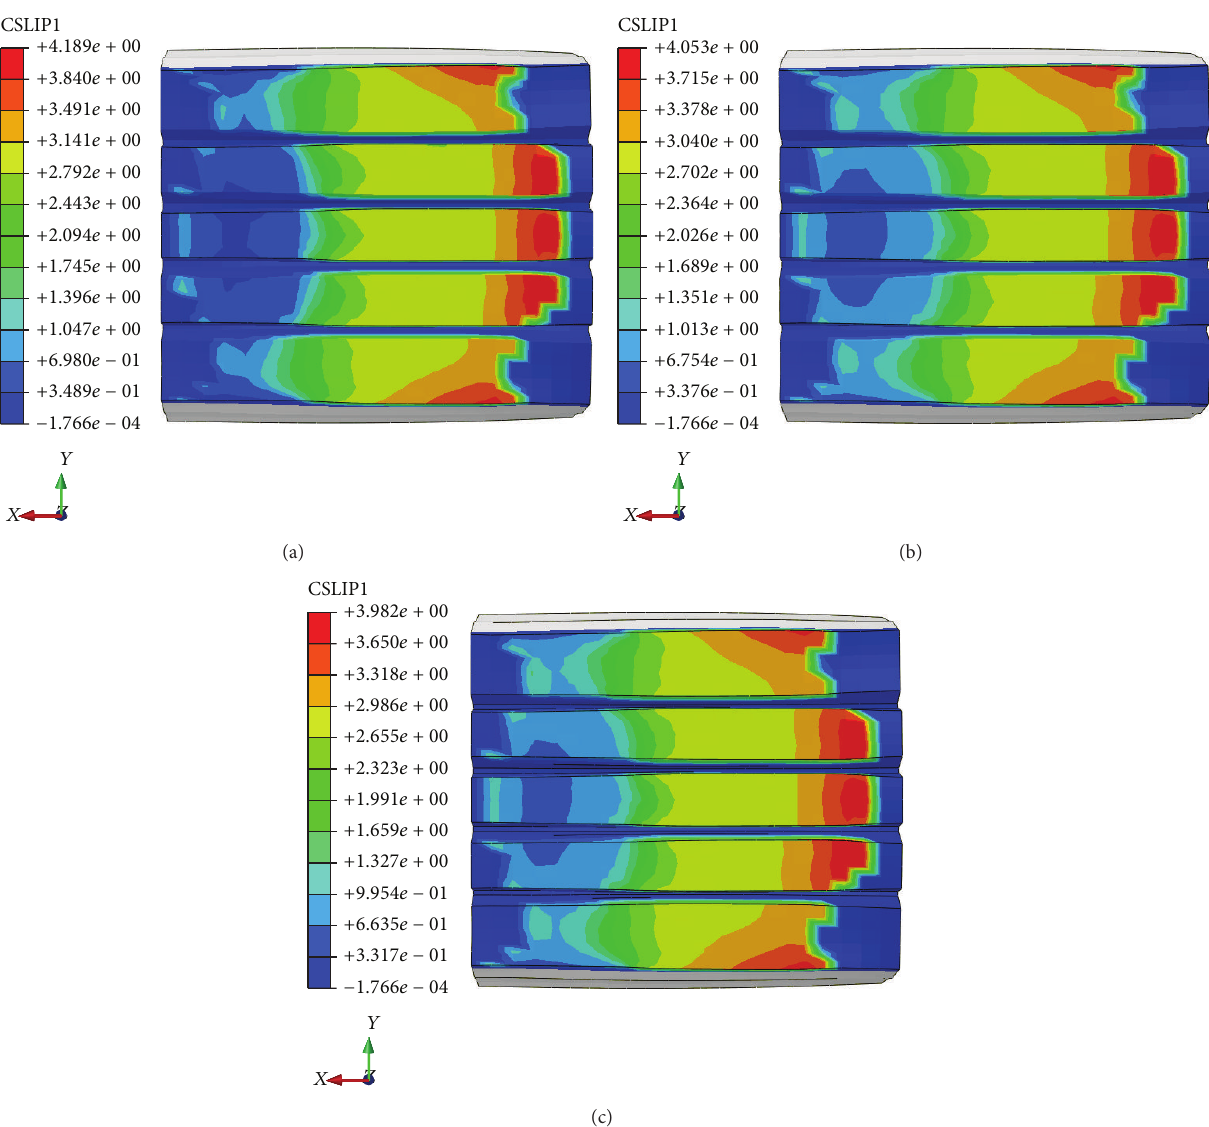
Figure 11: Effects of friction on contact area distribution at (a) 𝜇 = 0 . 85, (b) 𝜇 = 0 . 7 + 0 . 15 𝑒 − 0 . 5 𝑠 , and (c) 𝜇 = 0 . 7 + 0 . 15 𝑒 − 0 . 05 𝑠 .